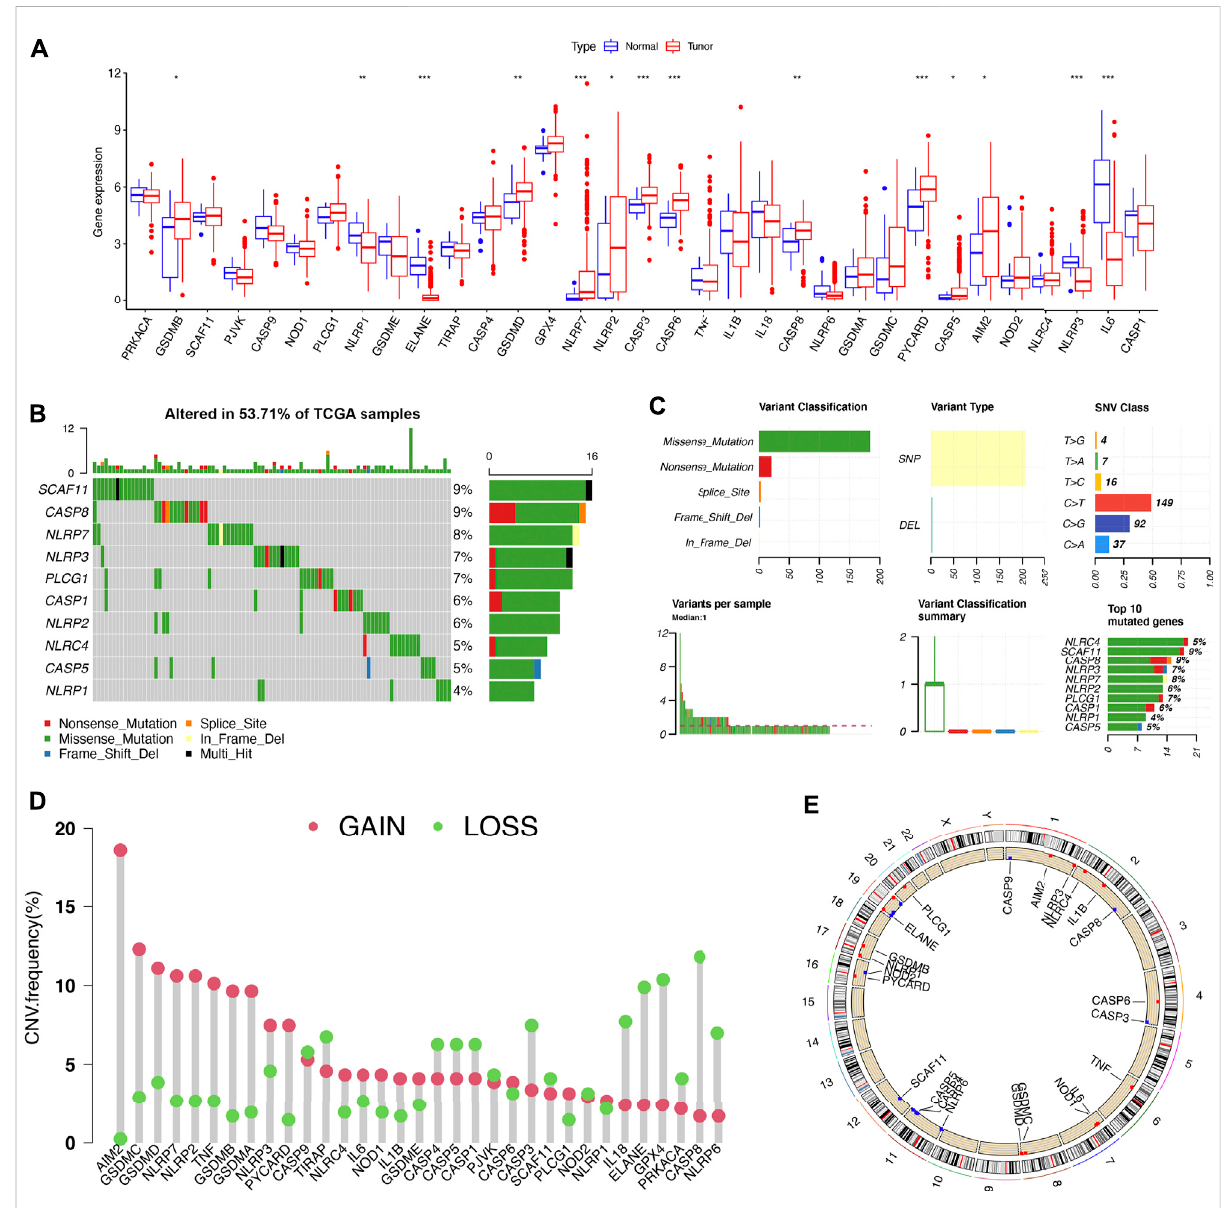
FIGURE 1 TheexpressionsandgeneticvariationsofPRGsinLUAD. (A) TheexpressionsofPRGsinbladdercancerandbladdertissues. (B,C) Thefrequency and classi fi cation of PRGs ’ genetic variations in bladder cancer. (D,E) The CNV variation frequency of PRGs and their corresponding location on 23 chromosomes in bladder cancer. The height of the column represents the alteration frequency. * p < 0.05; ** p < 0.01; *** p < 0.001, PRG, pyroptosis-related gene; CNV, copy number